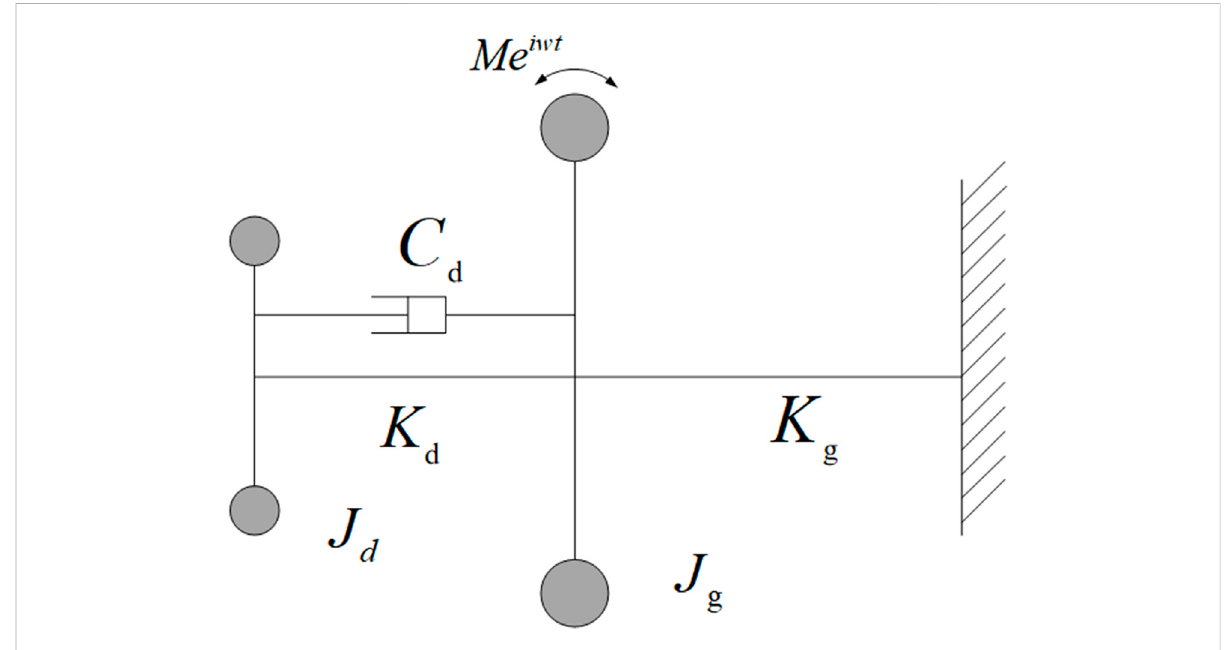
FIGURE 1 Equivalent model diagram of the double torsion pendulum